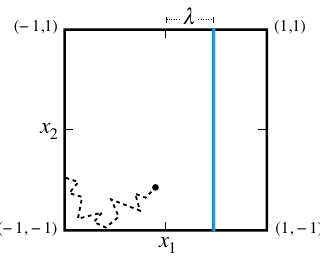
FIG. 4. A Szilard box with energy functions as in Eq.